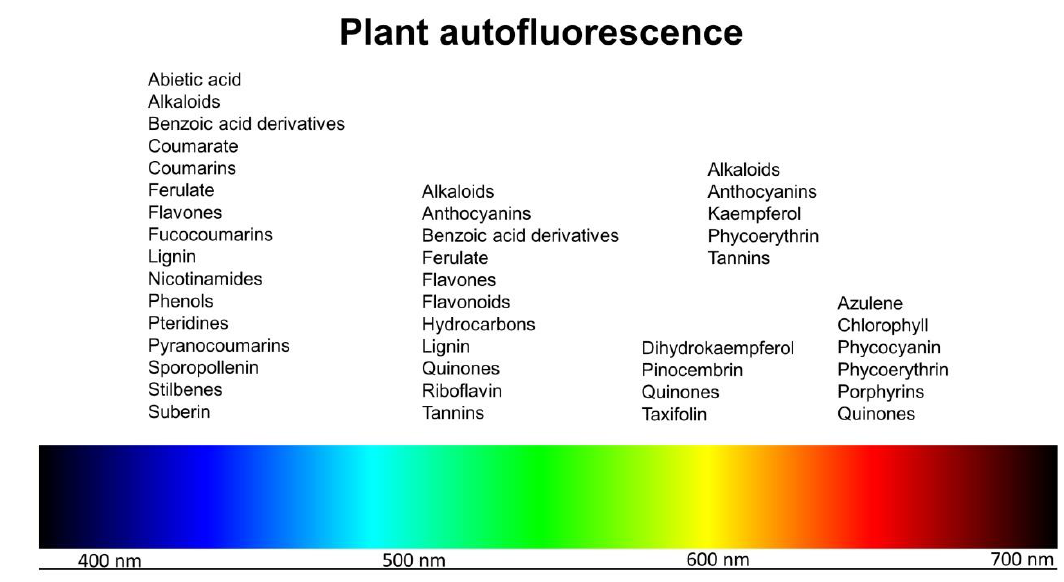
Figure 1. Fluorescence emission of common autofluorescent compounds found in plants [1 – 15].